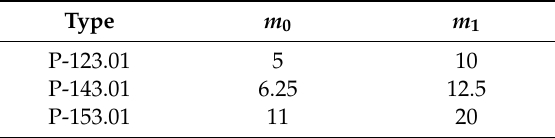
Table 4. The magnification factors of three products.